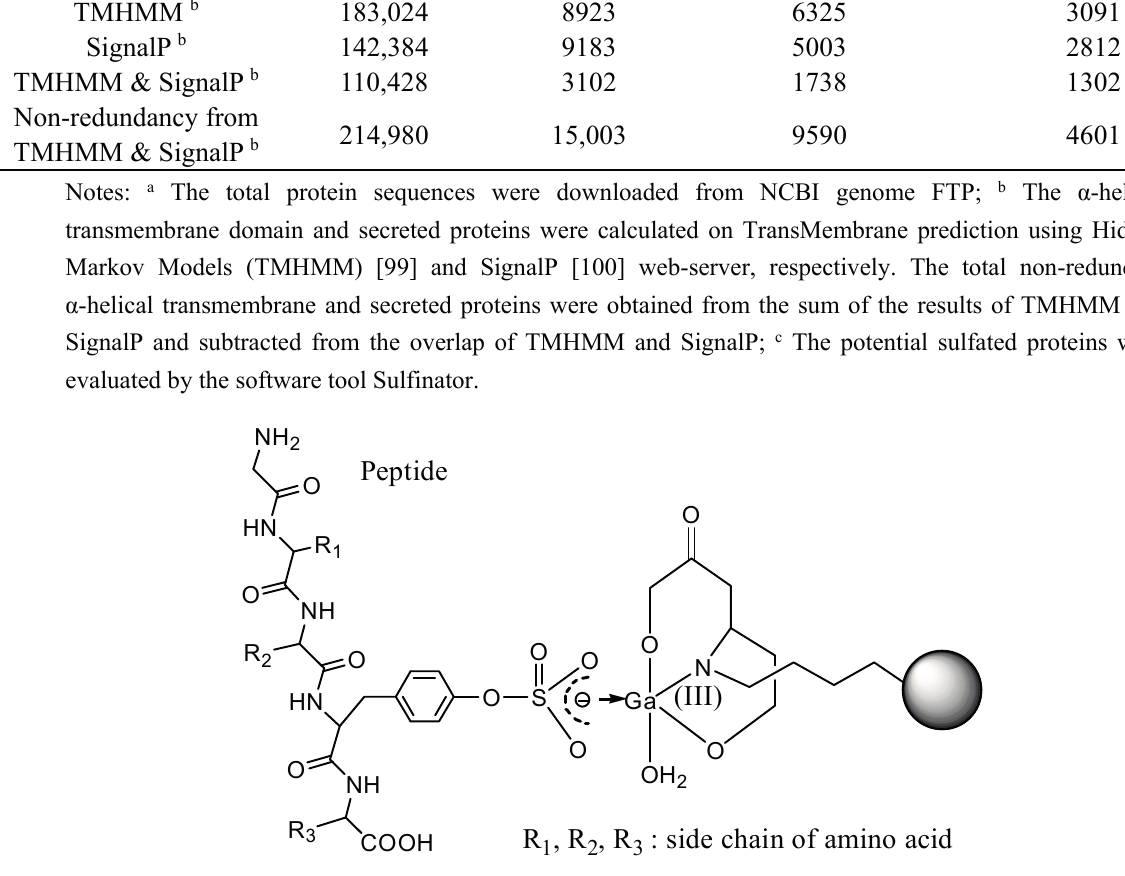
Figure 3. Immobilized metal ion affinity chromatography (IMAC-Ga) for the enrichment of sulfated protein. The structures of IMAC-Ga and its coordination with a sulfated tyrosine are shown. Methods for the enrichment of sulfated peptides and proteins are very useful for the detection of PTS that may be low in a cell.